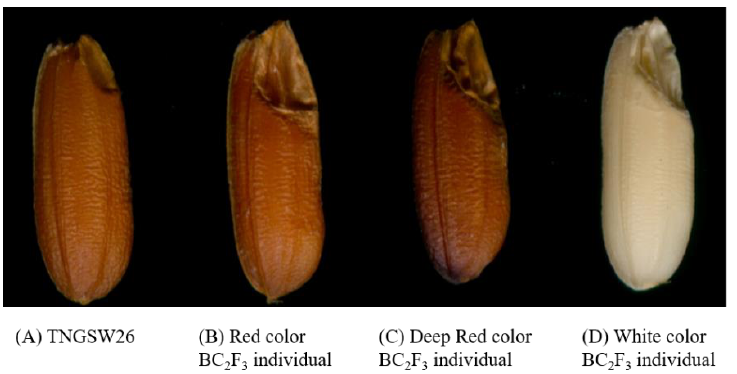
Figure 8. Grain appearance of brown rice for ( A ) TNGSW26 and ( B – D ) BC 2 F 3 individuals, which had larger embryos than TNGSW26.